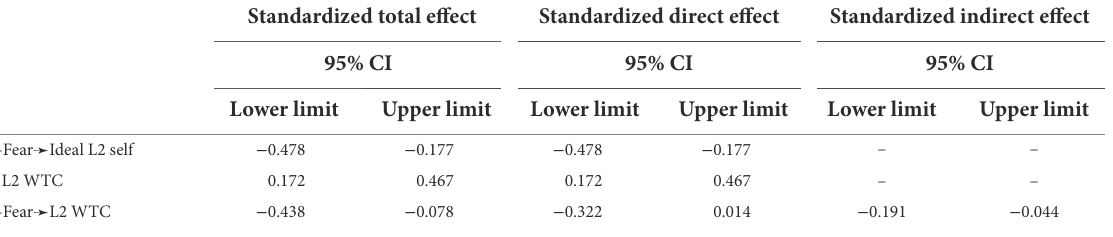
TABLE 5 Effect analysis of the paths (Social phobia-fear).